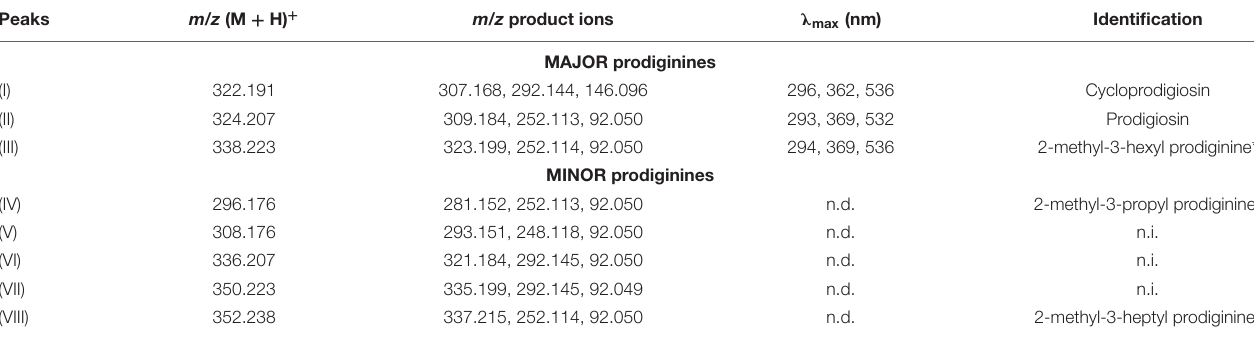
TABLE 1 | Dereplication of prodiginines produced by Pseudoalteromonas rubra #1783. Peaks m / z (M + H) + m / z product ions λ max